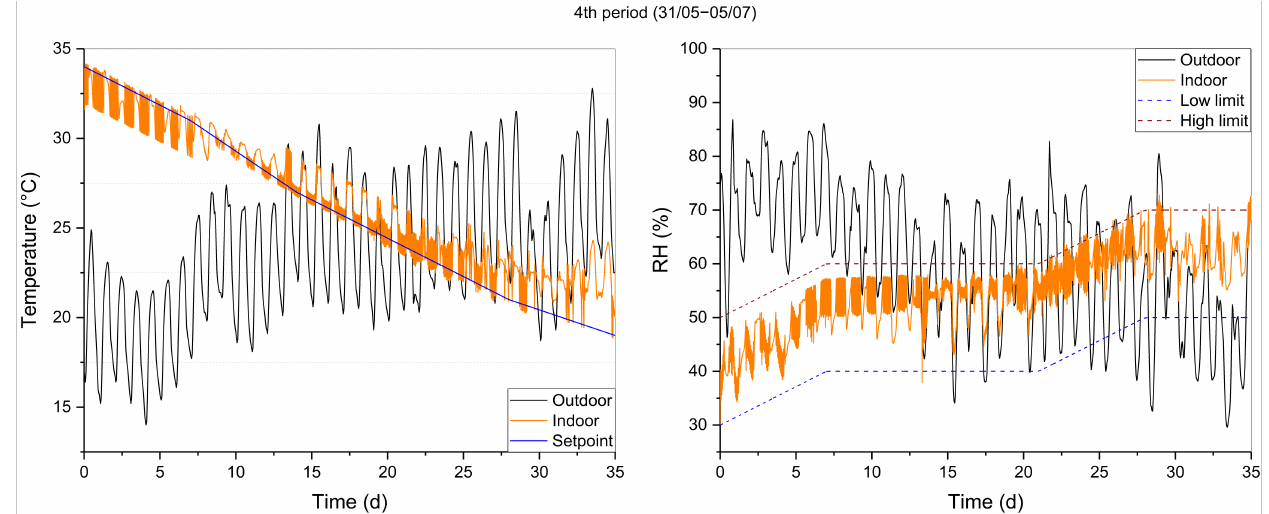
Figure 8. Temperatures and relative humidity variation during the 4th production period (31.05–05.07).